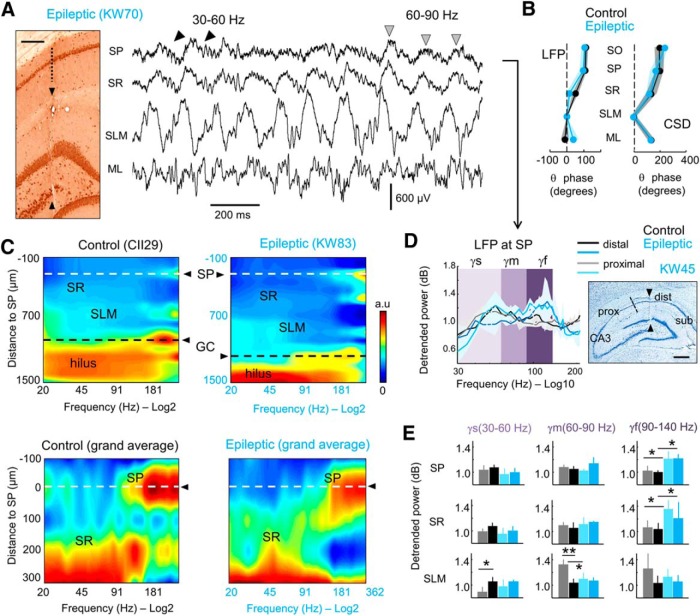
Different types of gamma activity recorded in the dorsal hippocampus of epileptic rats. A, Representative example of an epileptic rat recorded with 16-channel silicon probes during object exploration. Left, Coronal section immunostained against NeuN shows the probe track. Scale bar, 200 µm. Right, Representative LFP signals. Note gamma activity along the descending phase of some theta cycles at the SP (trace: 30–60 Hz, black arrowheads). Mid-gamma activity (60–90 Hz) is typically recorded at the positive theta peak of some cycles (gray arrowheads). SR, Stratum radiatum; ML, molecular layer of the dentate gyrus. B, Similar laminar phase shift of LFP and CSD theta cycles with respect to SLM (mean ± 95% confidence interval; n = 10 control, n = 8 epileptic). C, Spatial expression of gamma activity across hippocampal layers in a representative control and epileptic rat (top plot). Note the stereotyped profiles characterized by stronger activity at the hilus and distinct gamma bands at different layers. To avoid the hilar saturating effect, a grand average of three control and three epileptic rats recorded at comparable locations is shown at bottom along the SP and SR layers. D, Relative power after 1/f detrending from LFP signals recorded at the CA1 SP (mean ± 95% confidence interval). Data are grouped according to proximal (close to CA3) and distal [close to subiculum (sub)] recording locations (see scheme at right). The three gamma bands are indicated by different colors: gamma-s (γs; 30–60 Hz; light purple); gamma-m (γm; 60–90 Hz; purple); and gamma-f (γf; 90–140 Hz; dark purple). Right, Nissl staining section showing proximal and distal locations along with the probe track (arrowheads). Scale bar, 500 µm. E, Group differences on the three gammas for LFP recorded at SP, SR, and SLM from all rats. Data (mean ± SD) are presented as proximal (n = 5 control rats; n = 4 epileptic rats) and distal (n = 5 control rats; n = 4 epileptic rats) for SR and SLM layers. Note strong statistical differences accumulated at the fast gamma band. *p < 0.05; **p < 0.005